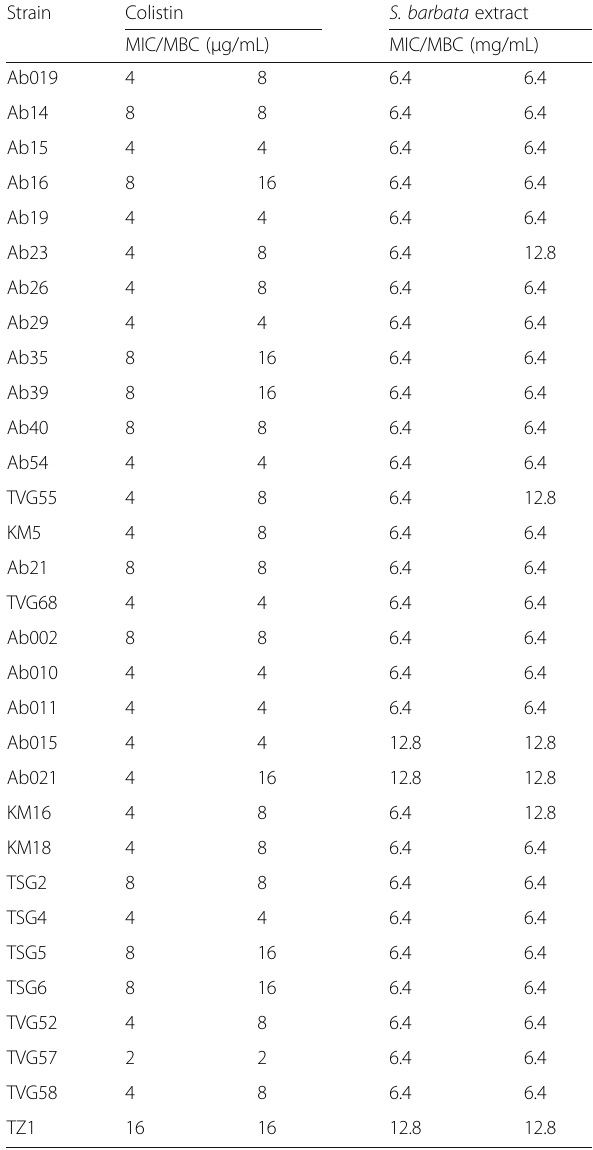
Table 2 MIC and MBC values of colistin and S. barbata extract against various A. baumannii strains Strain